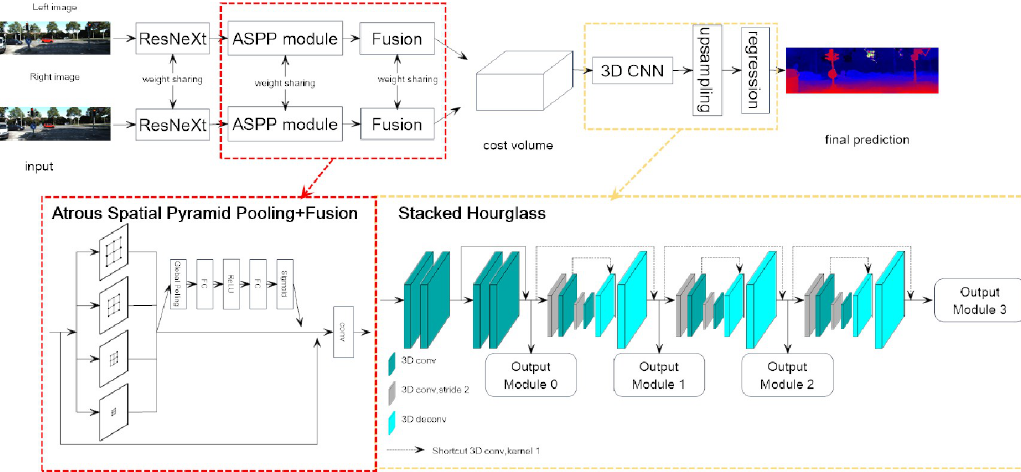
Fig 3. The pipeline of the proposed improved PSMNet network. The left and right images are input into two weighted residual convolution neural networks used to extract features, and the ASPP module is used to obtain the contextual information of images. Then, the left and right image features are connected to form a 4-D cost space, and the costs are regularized by a multiscale 3D CNN network. Finally, an accurate disparity map is obtained by disparity regression.